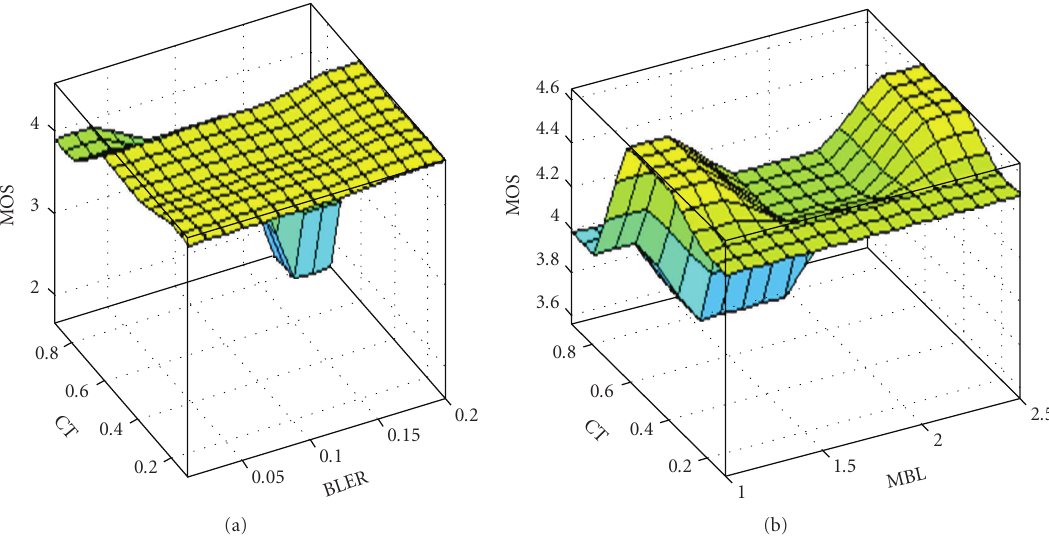
Figure 13: (a) MOS versus CT versus BLER. (b) MOS versus CT versus MBL.